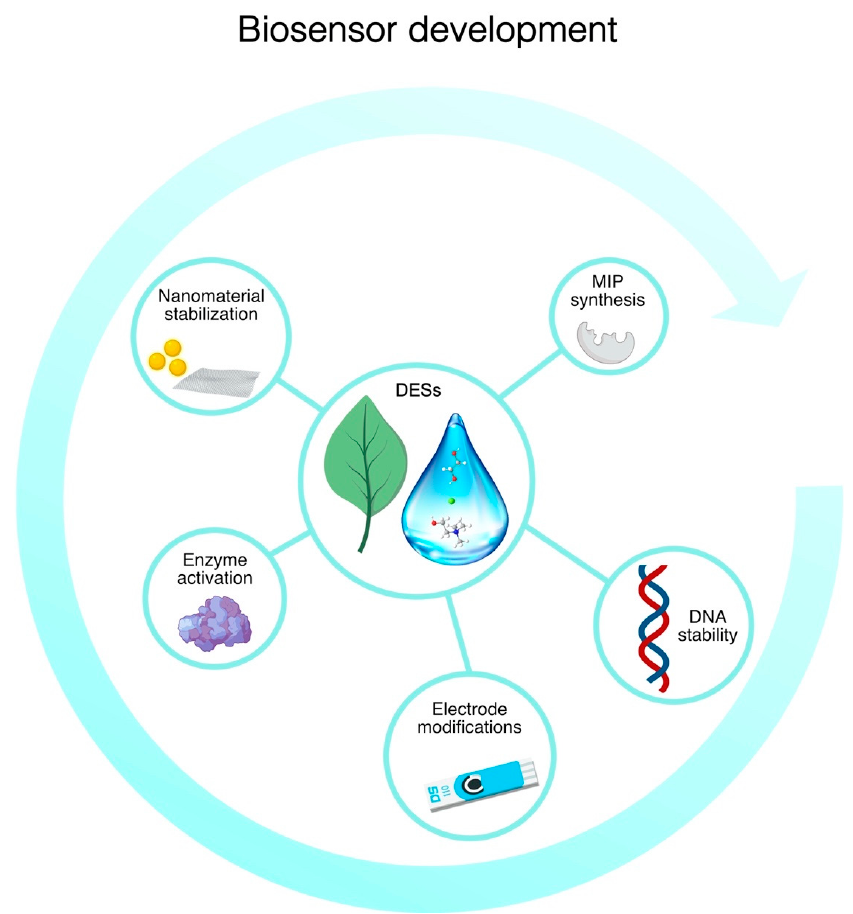
Figure 2. Overview of the general advantages of the use of DESs in biosensor development. The use of DESs can improve the performance of biosensors thanks to the biocompatibility of this class of solvents with the recognition elements and the improvement of electrode material performance.